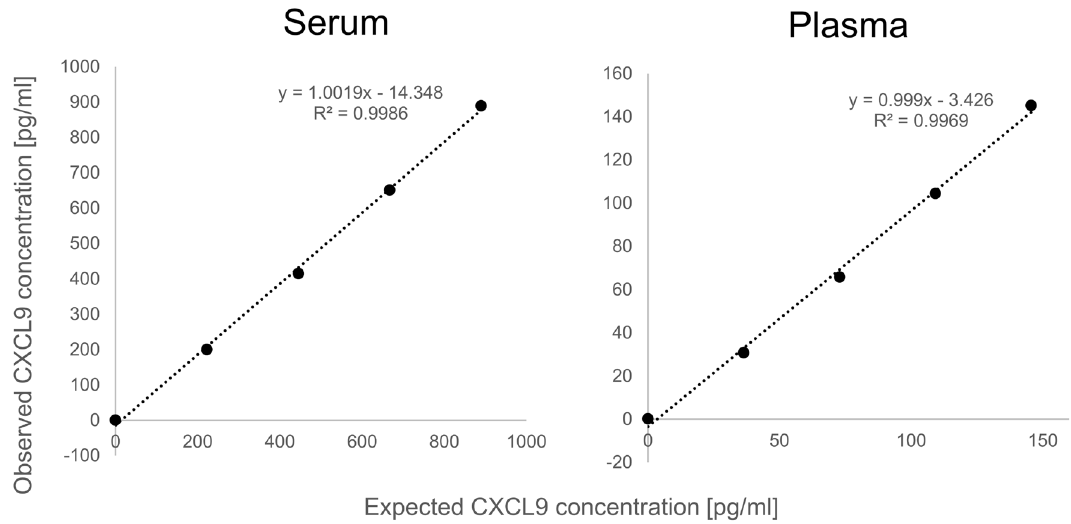
Figure 1. Dilution linearity. Linear regression analysis ( n = 3) of the HISCL CXCL9 immunoassay using serum and plasma samples. R 2 , coefficient of determination.